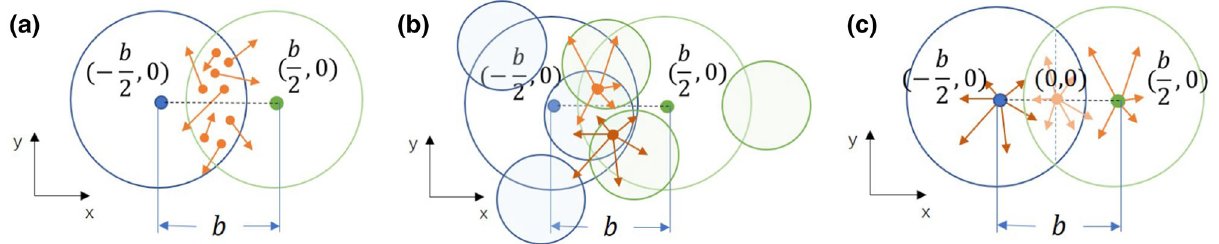
Fig. 1 An illustration of the spatial distributions of the parton sources in the transverse plane produced with our transport model approach using the overlap function weighting method ( a ) and the constituent quark method ( b ), together with the distributions from the full AMPT model ( c ). Filled green and blue circles represent the projectile and tar-